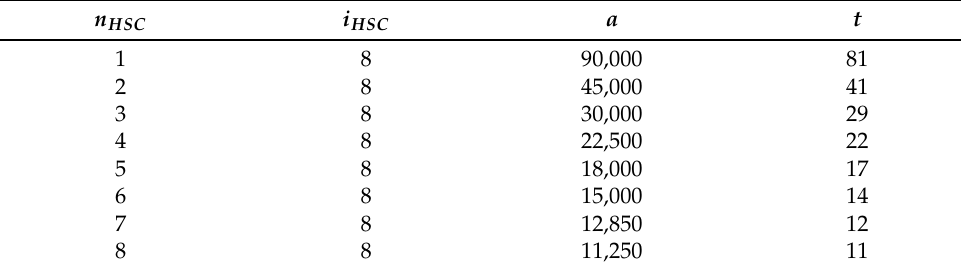
Table 5. Scalability of nodes with 8 GMAF instances